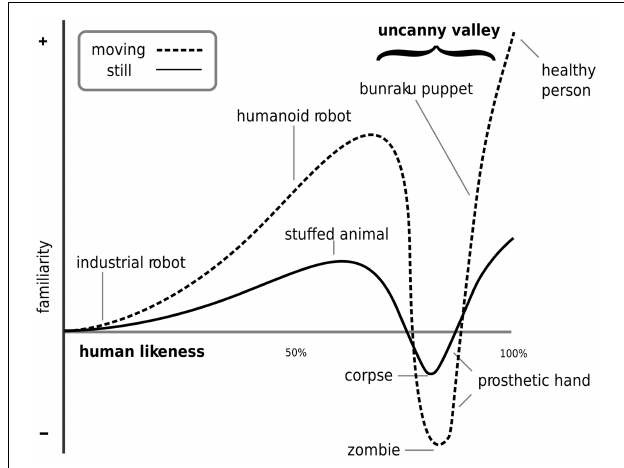
FIGURE 1 | The Uncanny valley. Mori describes the Uncanny valley as a non-linear relation between the perceived familiarity felt toward a thing and its human likeness (MacDorman et al.,